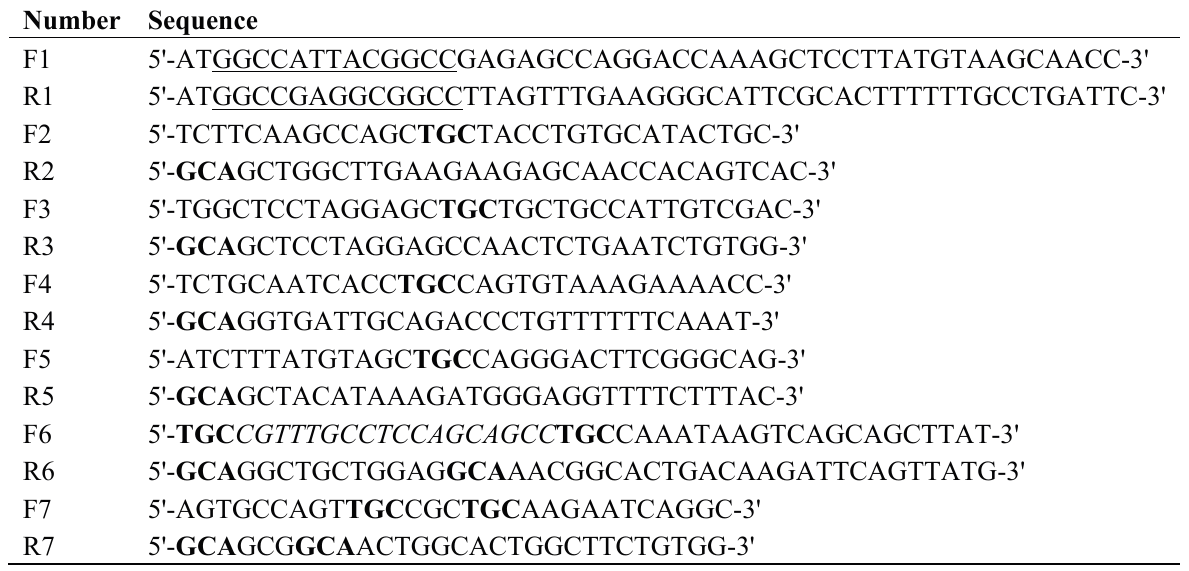
Table 3. Primers used for SelP